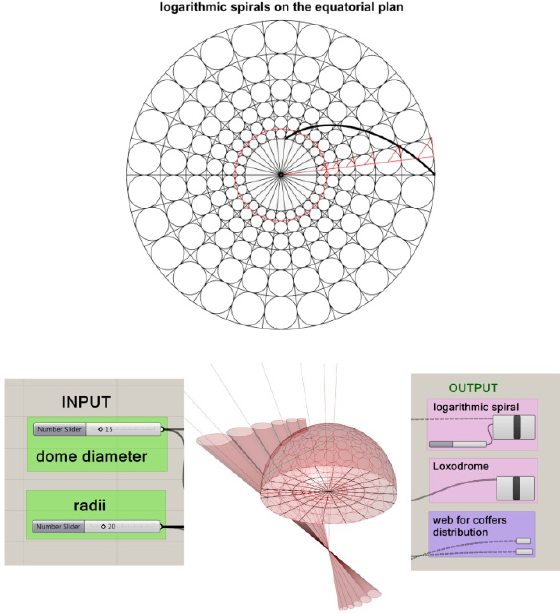
Figure 10. Generative modeling for coffers distribution on hemispherical dome starting to rules by